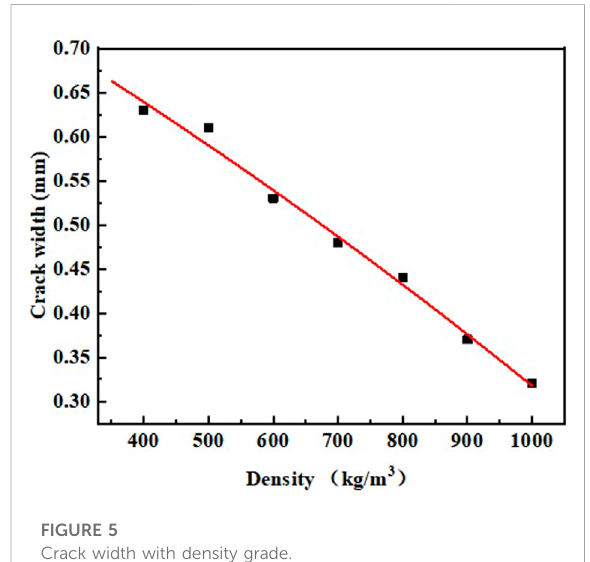
FIGURE 5 Crack width with density grade.